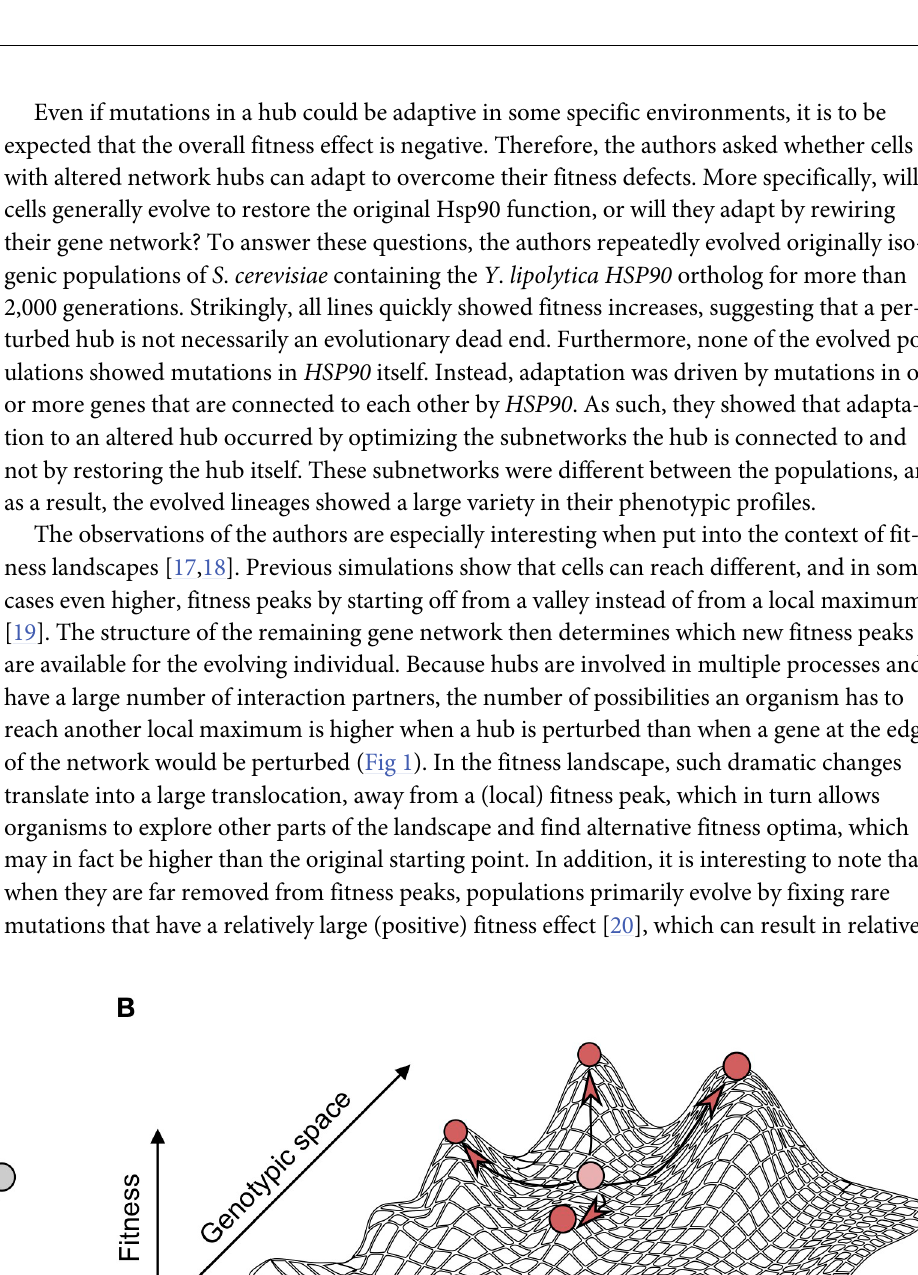
PLOS Biology | https://doi.org/10.1371/journal.pbio.3000111 January30,